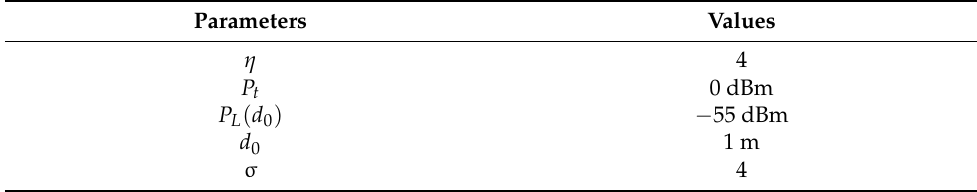
Table 1. Simulation parameters and values.